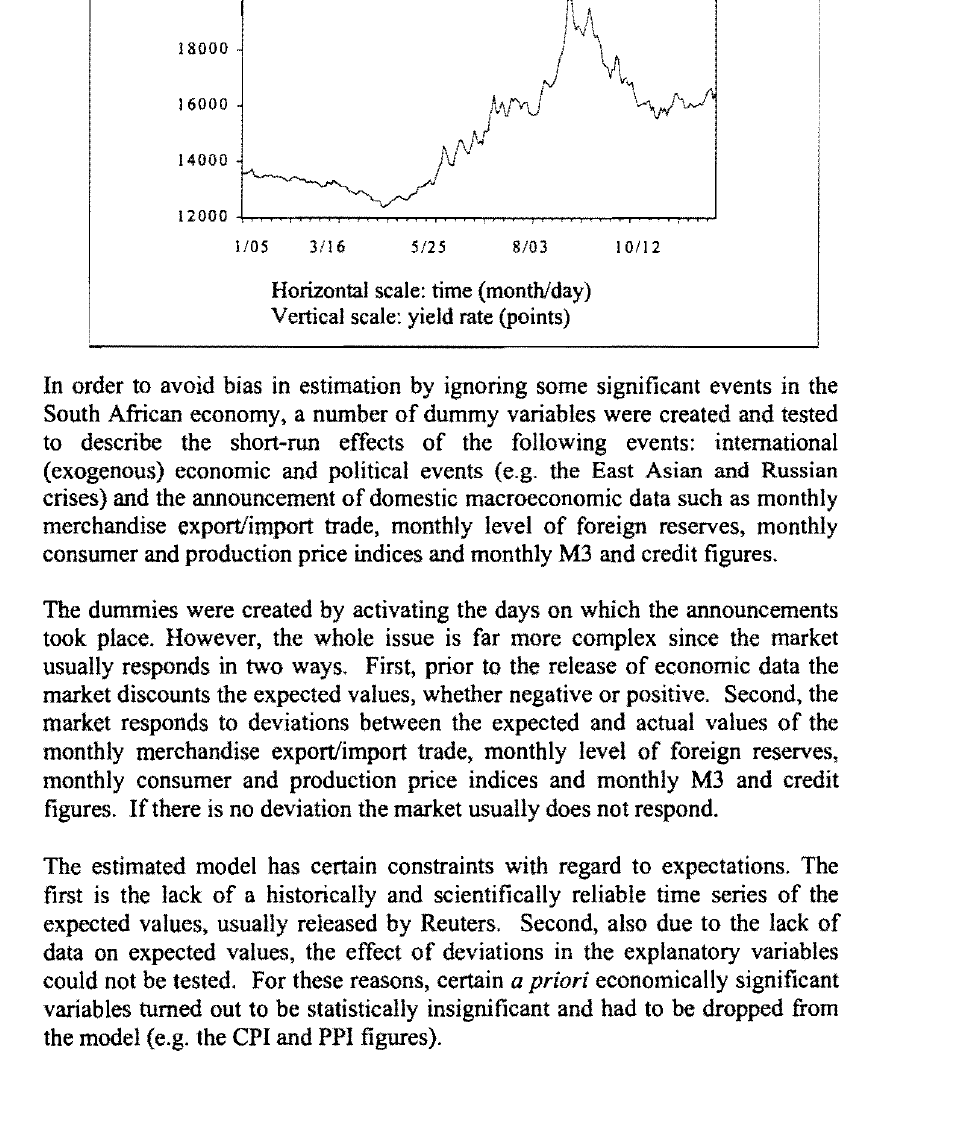
R1S0 yield rate, 1998